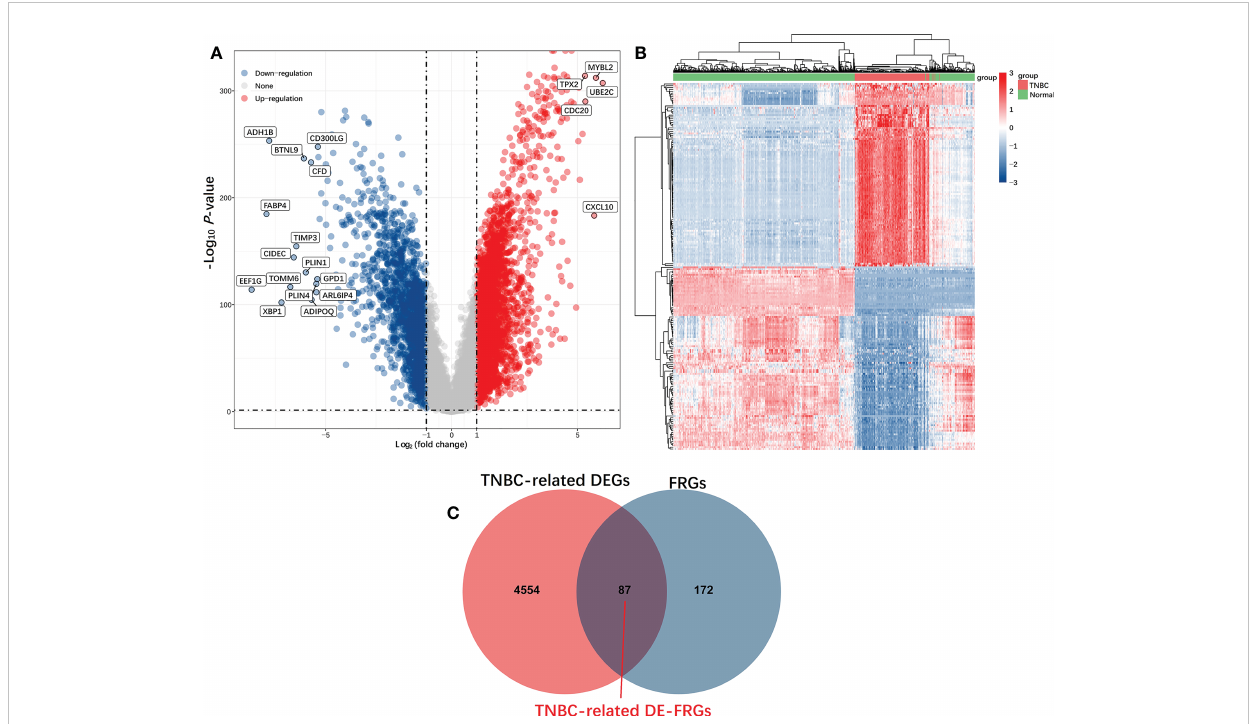
FIGURE 2 Identi fi cation of TNBC-related DE-FRGs in the TCGA database. DE-FRGs that were differentially expressed FRGs between TNBC tumors and healthy tissues (FDR < 0.05, |Log2 (Fold Change)| > 2) were presented in the form of Volcano plots (A) , in which blue and red dots respectively correspond to up-regulated and downregulated DE-FRGs; Heat maps (B) , in which each dot and its color (Red is high-expression, blue is low-expression) indicate the expression value of each DE-FRGs in different samples, the greater the expression level, the darker the color. (C) Venn diagrams were used to identify TNBC-associated